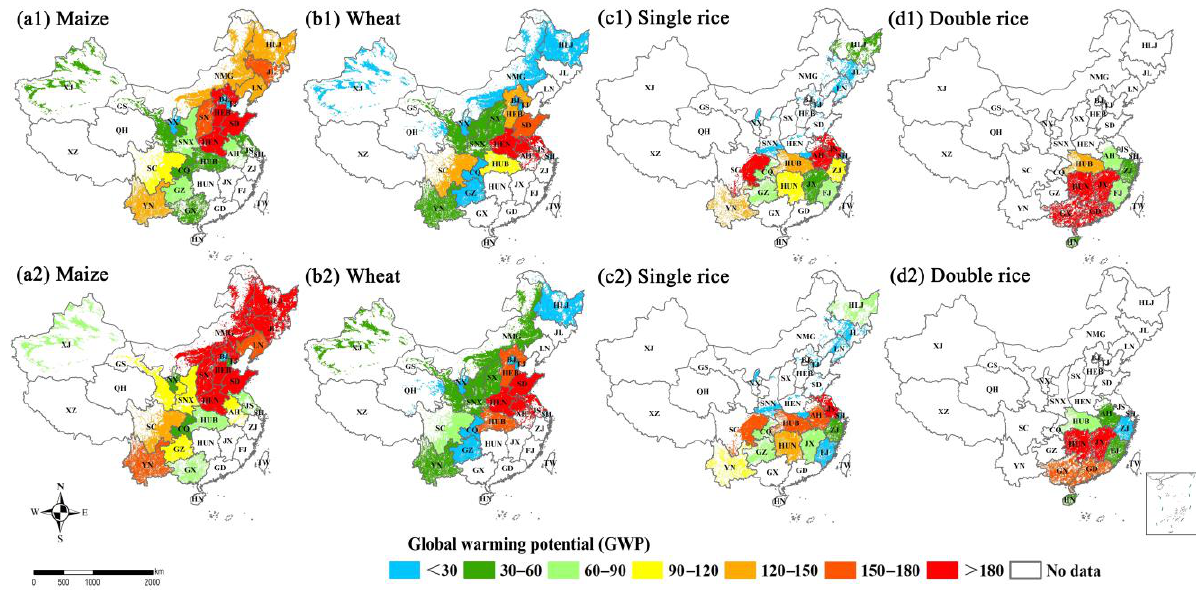
Figure 5. The global warming potential (GWP) between 2004–2008 and 2014–2018 for ( a1 , a2 ) maize, ( b1 , b2 ) wheat, ( c1 , c2 ) single rice and ( d1 , d2 ) double rice at provincial scale in China’s farmlands, respectively.